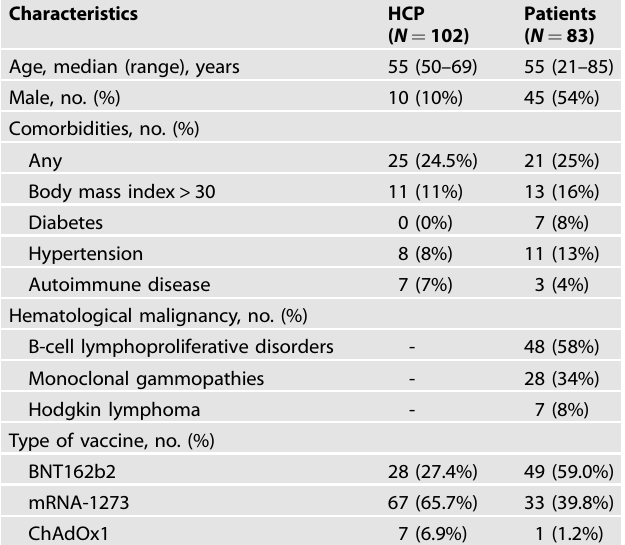
Table 2. Seroconversion in 83 patients with hematological